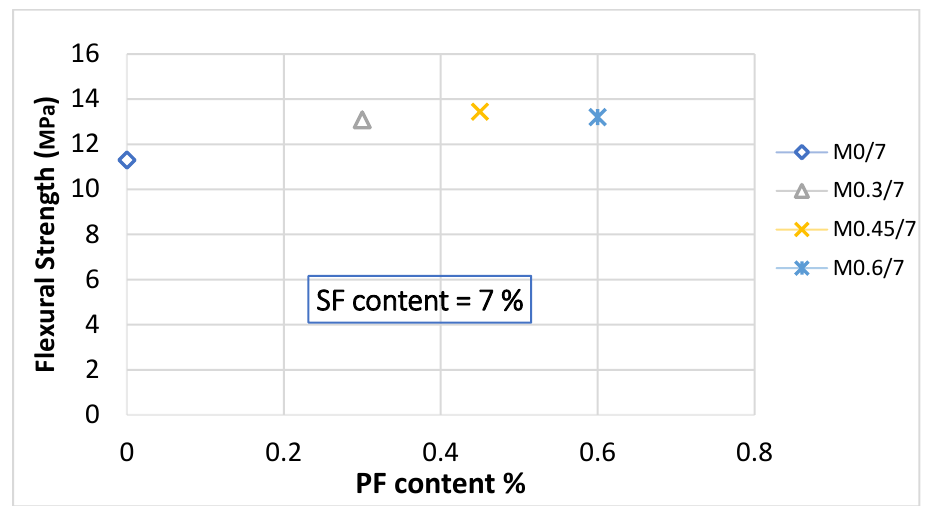
Figure 15. Effect of polypropylene fiber content on flexural strength under ambient conditions.